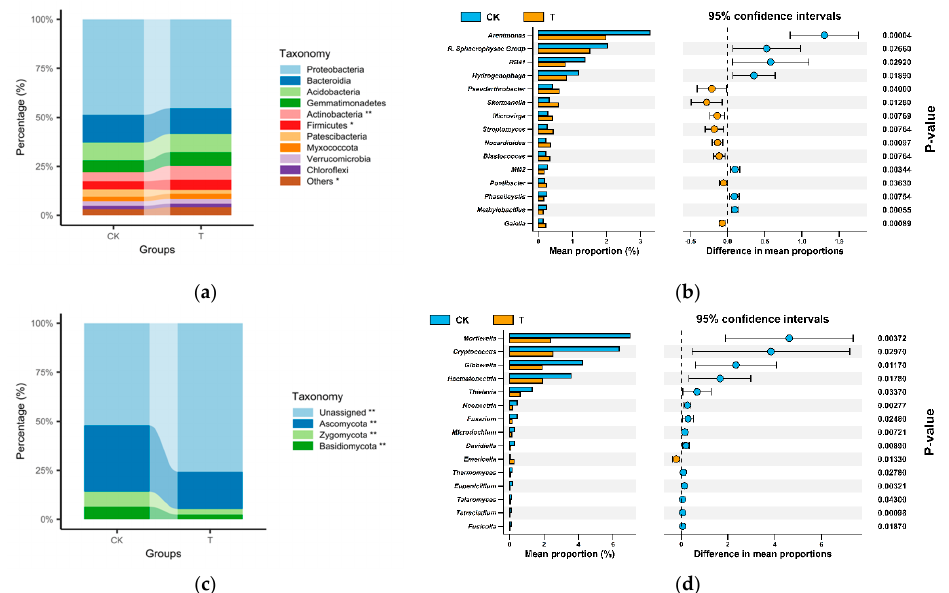
Figure 3. The relative abundances of major bacterial ( a ) and fungal ( c ) phyla, and the top 15 genera of bacteria ( b ) and fungi ( d ) with significant differences in relative abundance, in the rhizosphere soils of cucumber inoculated with Streptomyces (T) and without Streptomyces inoculation (CK). * p < 0.05; ** p < 0.01.